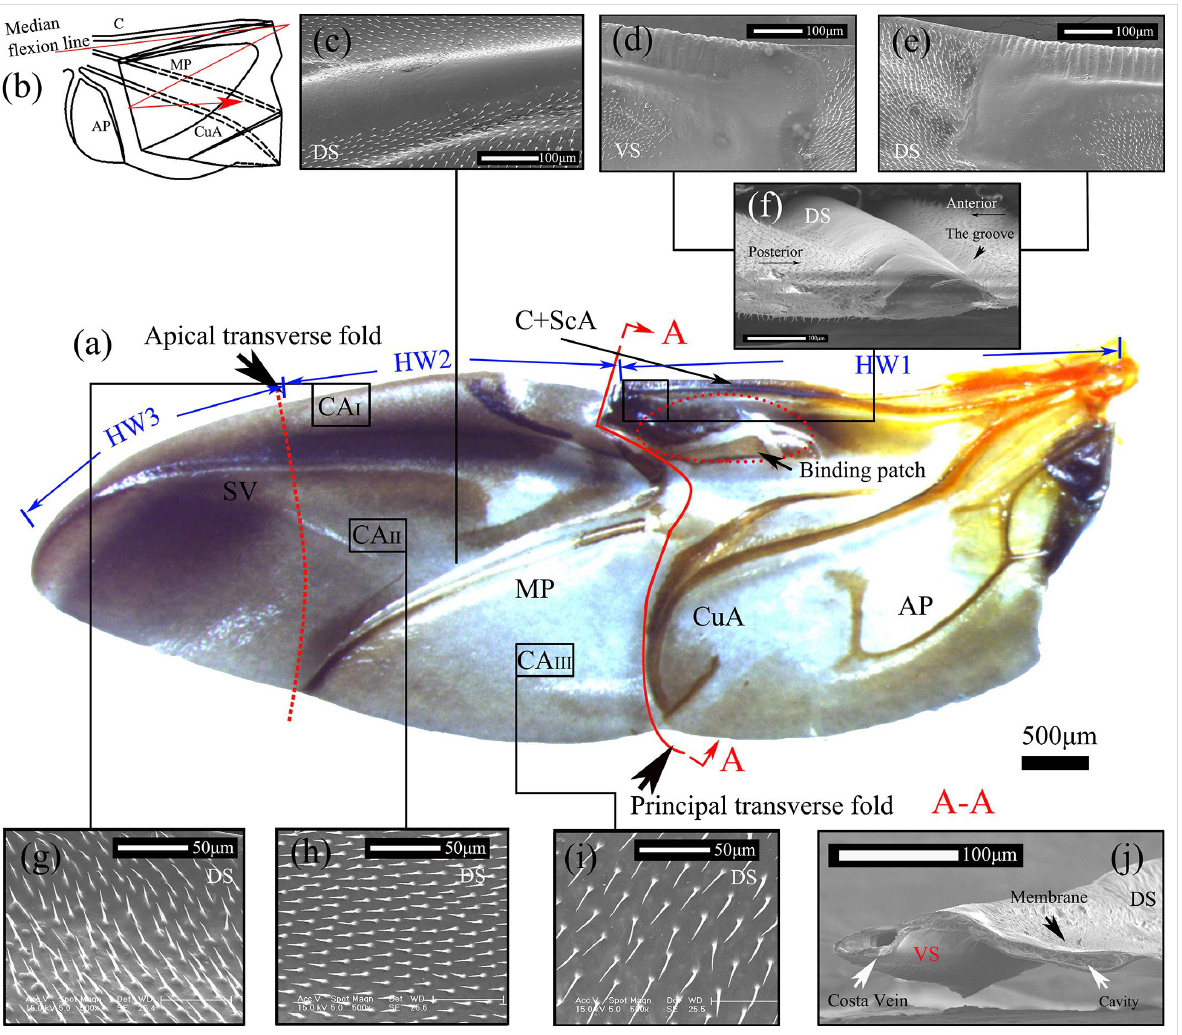
Figure 2: The DS of the hindwing of H. axyridis in an unfolded state (a) and a folded state (b). (c) shows the detailed microstructure of the corrugated membrane. (e) and (d) show the microstructural details of the end of the costal vein and its DS and VS, respectively; the microtrichia were sparse around the fold line but were dense away from the fold line. They were regularly distributed in the (g) costal field, (h) claval field, and (i) vannal field. (f) and (j) show cross sections of the costal vein in the principal transverse fold. C, costa; ScA, subcosta anterior; MP, media posterior; CuA, cubitus anterior; AP, anal posterior; SV, supporting vein. CAI, CAII, and CAIII are the regions used for measuring CAs. HW1–3 represent different folding seg- ments of the hindwings